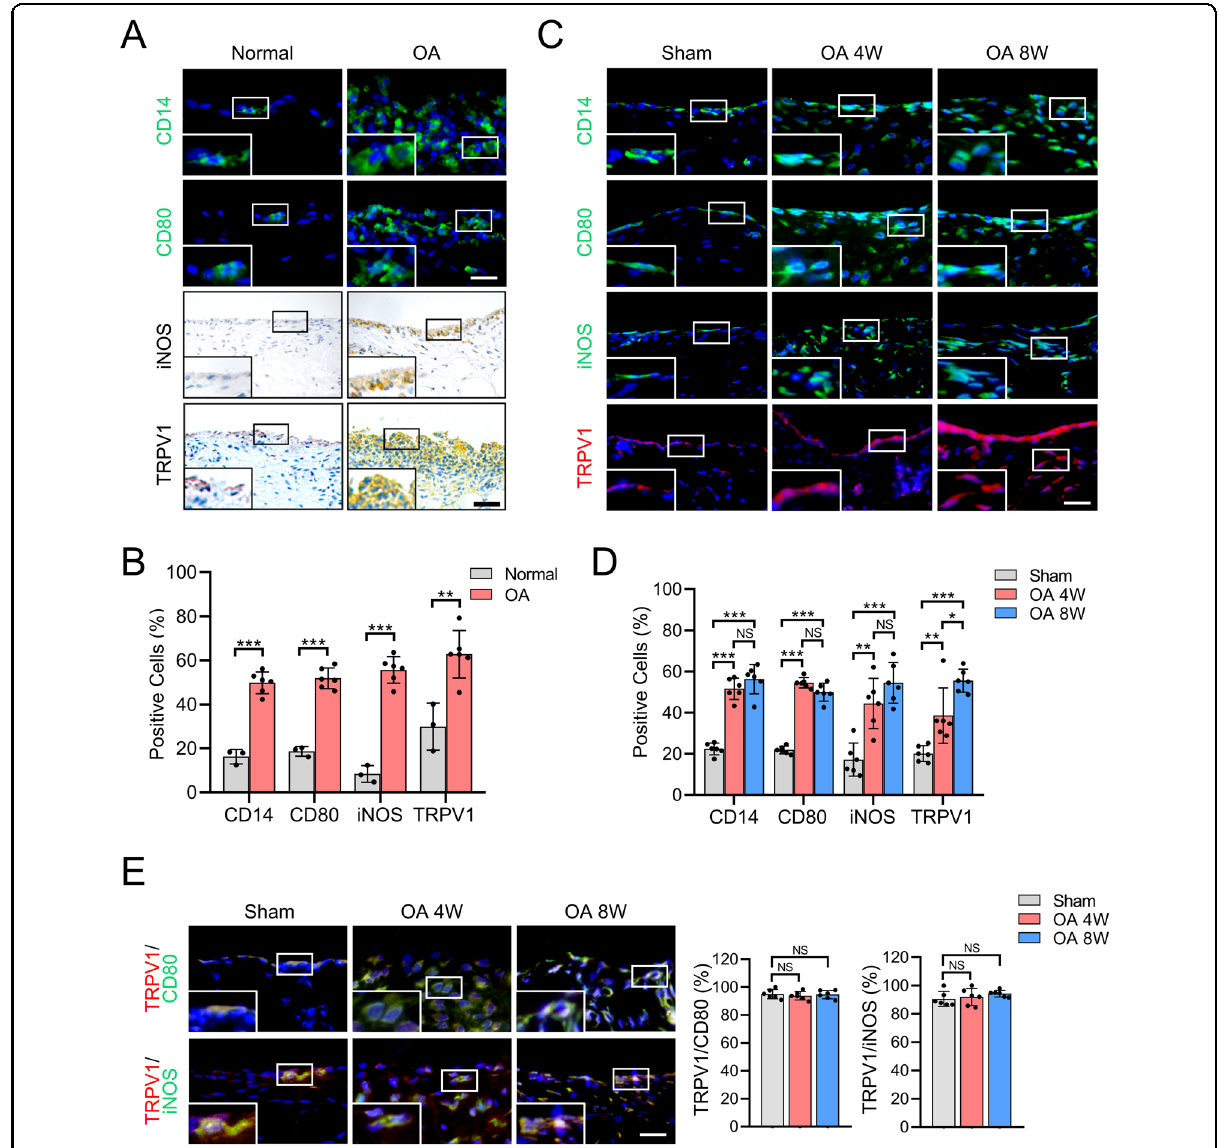
Fig. 1 TRPV1 expression and M1 macrophage in fi ltration in the synovium of OA patients and rat OA model. A Immuno fl uorescence images for CD14 and CD80 staining, and immunohistochemical staining for iNOS and TRPV1 in normal and OA human synovium. B Quanti fi cation of CD14-, CD80-, iNOS-, and TRPV1-positive cells as a proportion of total cells in normal ( n = 3) and OA ( n = 6) human synovium. C Immuno fl uorescence images for CD14, CD80, iNOS, and TRPV1 in the synovium of sham and rats at 4 and 8 weeks after the radial transection of the medial meniscus. D Quanti fi cation of CD14-, CD80-, iNOS-, and TRPV1-positive cells as a proportion of total cells in the synovium of sham and 4- and 8-week-old OA rats ( n = 6). E Co-immunostaining of TRPV1 with CD80 or iNOS in the synovium of sham and 4- and 8-week-old OA rats, and quantitative analysis of TRPV1-positive macrophages compared to total CD80- or iNOS-positive cells in the synovium of sham and 4- and 8-week-old OA rats ( n = 6). Enlarged image is in the boxed area in the bottom left corner. Scale bars: 25 μ m. Data are shown as mean ± SD. * P < 0.05; ** P < 0.01; *** P < 0.001; NS nonsigni fi